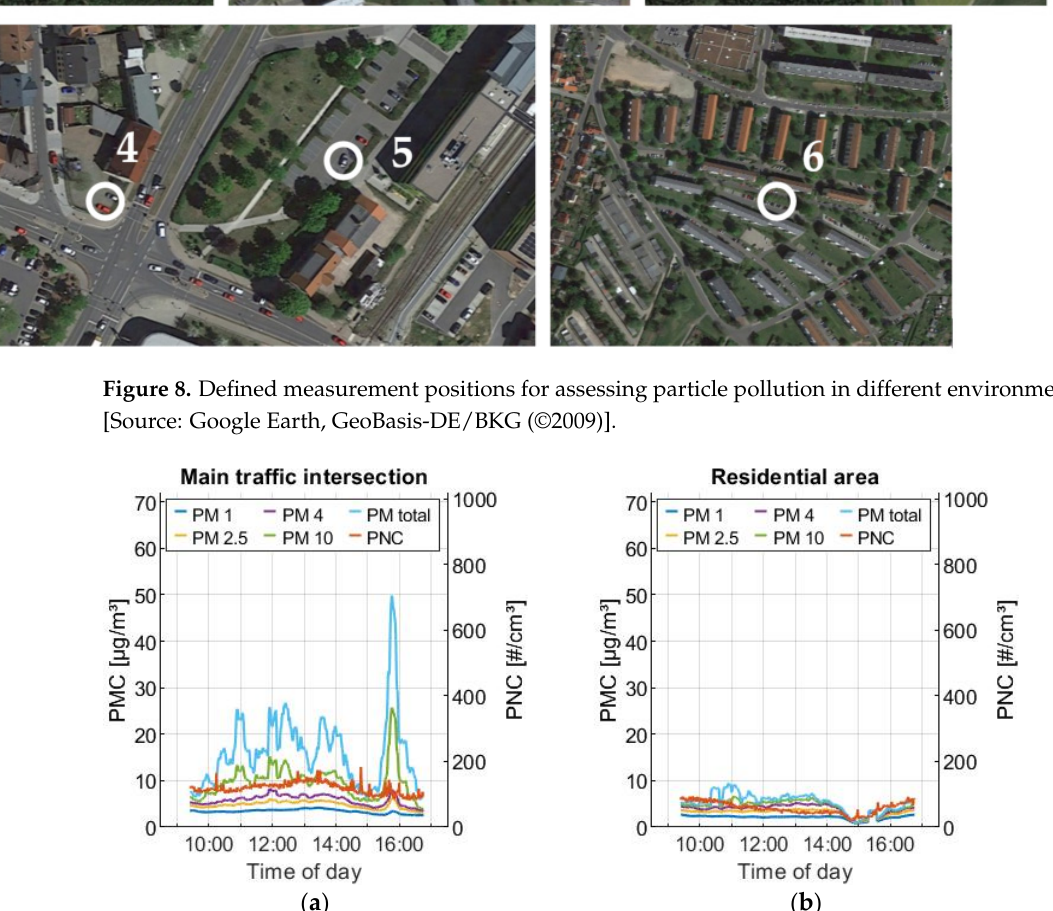
Figure 9. ( a ) high traffic volume (main traffic intersection); ( b ) low traffic volume (residential